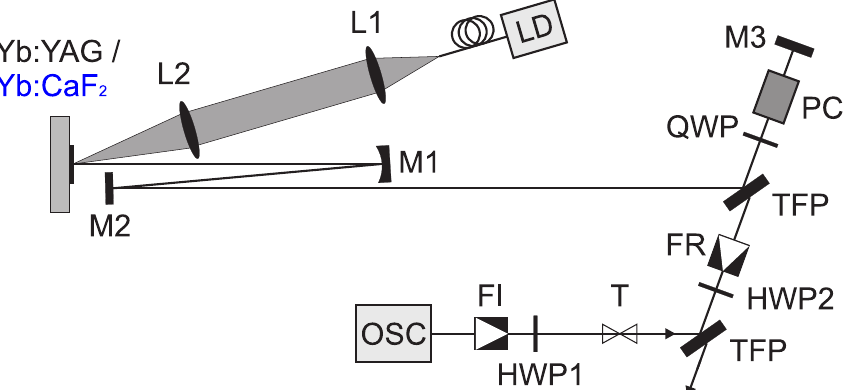
Figure 1. Experimental setup: OSC, fs mode-locked Yb:KGW oscillator; FI, Faraday isolator; FR, Faraday rotator; TFP, thin-film polarizer (angle of incidence: 62 ◦ ); QWP, HWP1 and HWP2, quarter/half-wave plates; T, spherical lens telescope (magnification: 1); PC, BBO-Pockels cell; LD, 11 W fiber coupled laser diode; L1, L2, spherical lenses with 25 mm diameter ( f 1 = 50 mm, f 2 = 75 mm); M1, dielectric concave mirror with radius of curvature: 300 mm; M2, M3, dielectric flat mirrors (HR 0 ◦ , 1010–1060